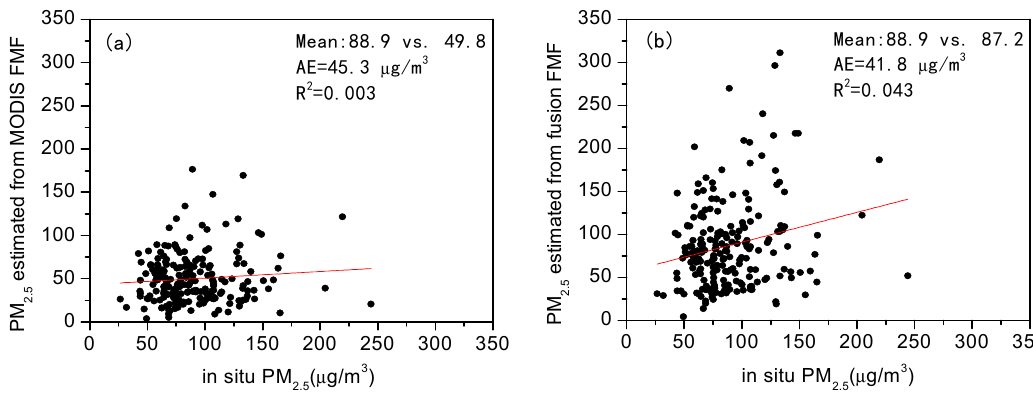
Figure 7. ( a ) Comparison between in situ PM 2.5 and PM 2.5 estimated from MODIS FMF; ( b ) Comparison between in situ PM 2.5 and PM 2.5 estimated from FMF fusion results. Note that the red lines are the fitted regression lines.